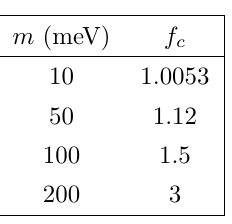
Table 1 . The enhancement factor, f c , due to neutrino clustering by our Galaxy and nearby galaxies for given values of neutrino masses